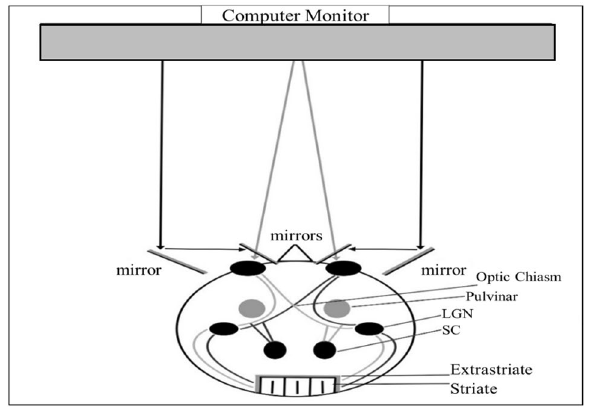
Figure 1. Schematic illustration of the experimental apparatus and visual pathways from the eyes to the brain. Each side of the computer monitor provided visual information to a different eye. From the eye, the visual information passes first through monocularly segregated subcortical regions (grey lines: left eye; black lines: right eye). This information is then projected to the lateral geniculate nucleus (LGN) and subsequently reaches striate and binocular extrastriate